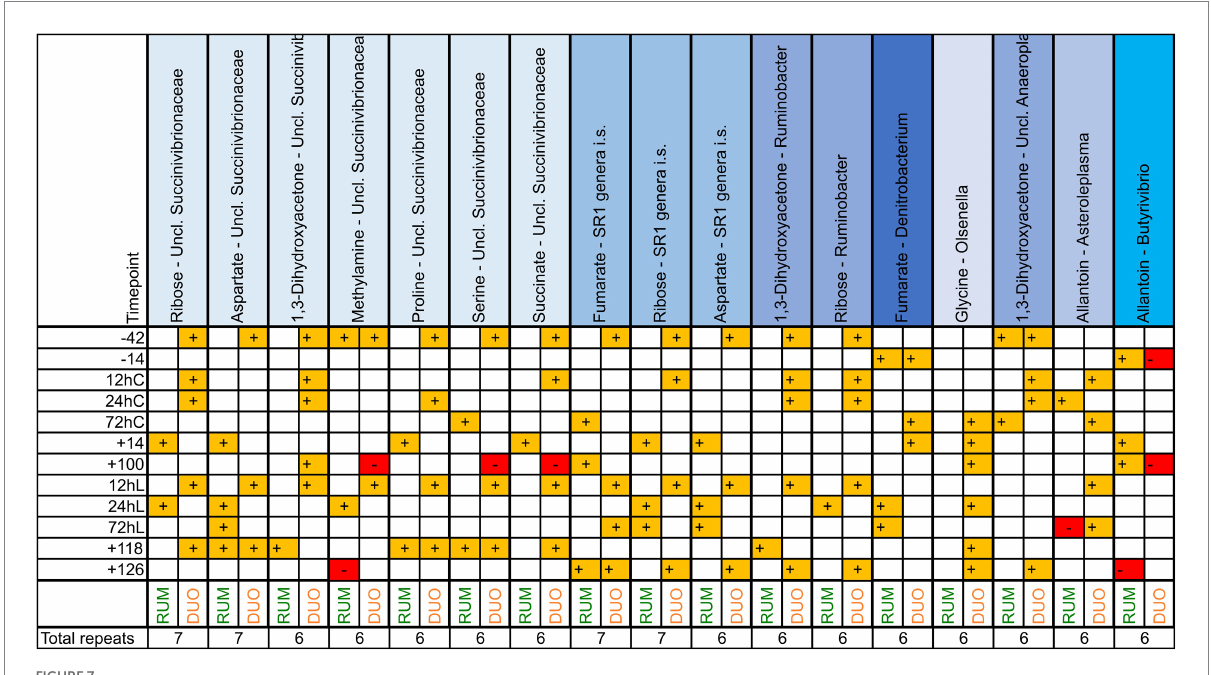
FIGURE 7 Significant ( p ≤ 0.05) correlation combinations of ruminal (RUM, N = 66) and duodenal (DUO, N = 67) metabolites ( N = 60) and genera ( N = 102) repeating at least 7 times across 12 time points using Pearson product–moment multivariate correlations. Time points including a “–” or “+” indicate days antepartum or postpartum and time points including “hC” or “hL” are samples taken at 12, 24, or 72 h after calving or LPS challenge,